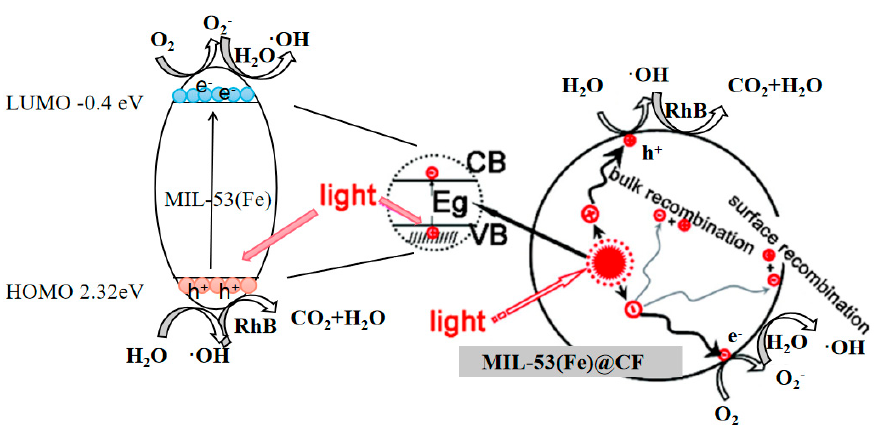
Figure 8. MIL-53(Fe)@CF membrane photocatalytic degradation of RhB [29,30].